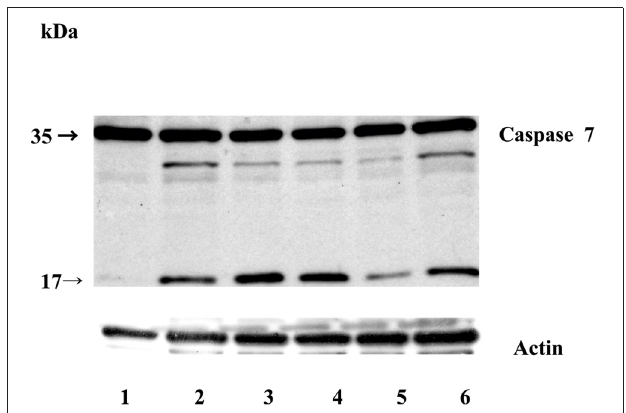
FIGURE 4 | Caspase-7 activation during STS-induced apoptosis in T98G cells. Equal amounts of proteins (70 μ g) were loaded and separated on 12,5% SDS-PAGE, followed by Western blotting with anti-caspase-7 monoclonal antibody F5/1 (Gregorc et al.). Membranes were stripped and re-developed with anti-actin Ab. Track 1: control (untreated cells); 2: T98G cells; track 3: T98G with an empty vector pcDNA3, track 4: T98G cells overexpressing stefin B into the cytosol; track 5: T98G cells overexpressing stefin B into the nucleus (NB); track 6: control cells transfected with an empty pEF/myc/nuc vector (NO). The data represent the mean of triplicate data points ± S.E. and are representative of three independent experiments. The data are representative of three independent experiments.